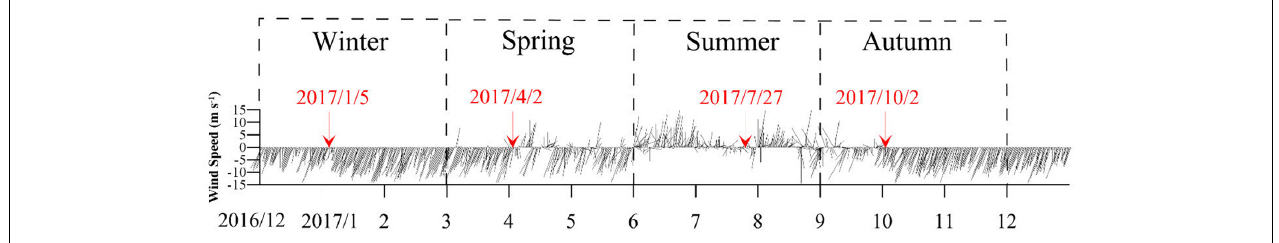
FIGURE 2 | Average daily wind observation data from the Central Weather Bureau of Taiwan at Penghu Weather Station in 2017, and the sampling dates were indicated. Positive values represent a wind direction between 90 ◦ and 270 ◦ .